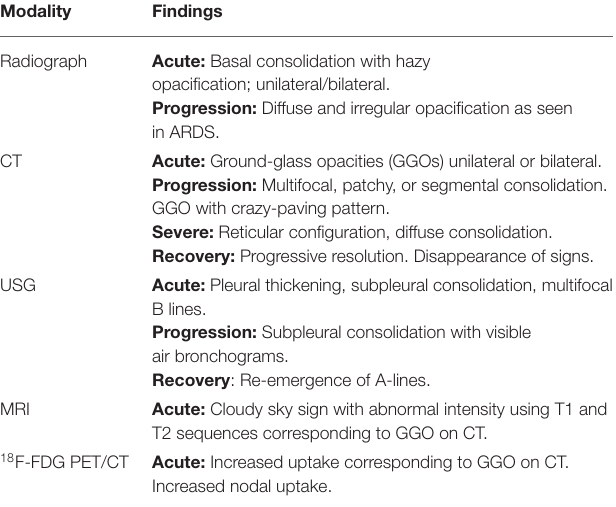
TABLE 1 | Pulmonary imaging features of COVID-19.